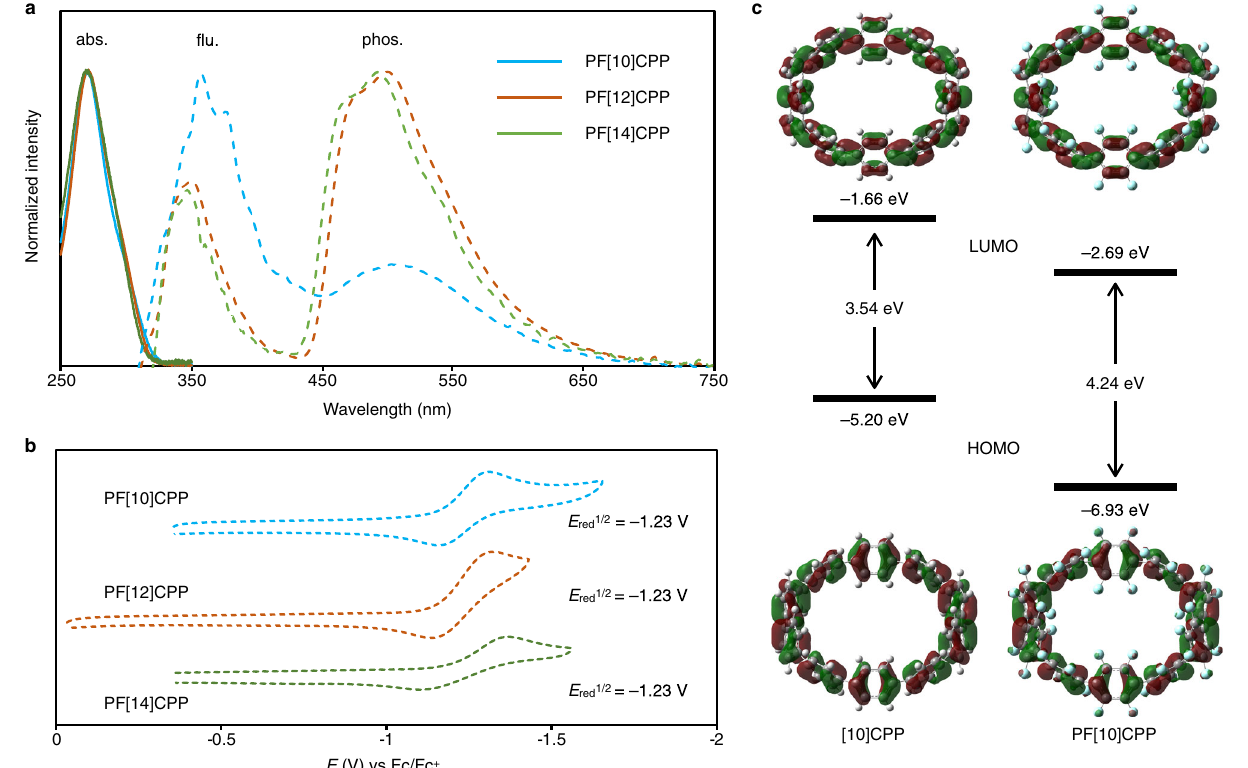
Fig. 4 Photophysical properties of PF[n]CPPs ( n = 10, 12, 14). a UV – Vis absorption spectra of dichloromethane solutions of PFCPPs at room temperature (solid lines), and photoluminescence spectra of PFCPPs in ethanol grass at 77 K upon excitation at 270 nm (dashed lines); blue: PF[10]CPP; red: PF[12] CPP; green: PF[14]CPP. b Cyclic voltammograms of PFCPPs in acetonitrile (supporting electrolyte: [ n -Bu 4 N][PF 6 ]; scan rate: 0.1 V s − 1 ). c Frontier molecular orbitals (isovalue: 0.02) and their energies (eV) of [10]CPP and PF[10]CPP calculated by B3LYP/6-31G(d) level of theory. Fc